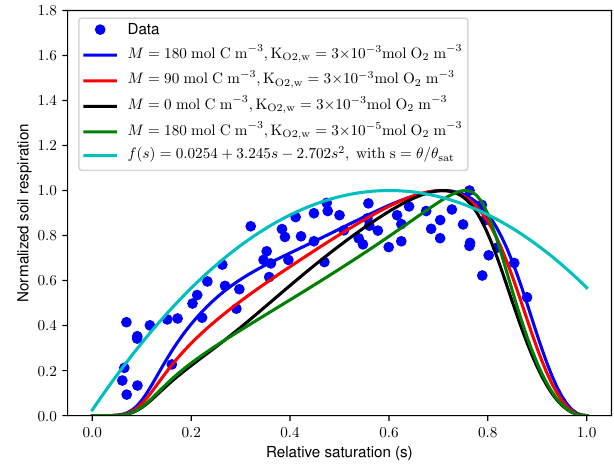
Figure 4. Model predicted consumer–substrate complexes as a function of the relative abundance of consumers with respect to substrates. Corresponding to Fig. 3, panels (a) and (b) are for the case when M = 0; panels (c) and (d) are for uniformly distributed M > 0.